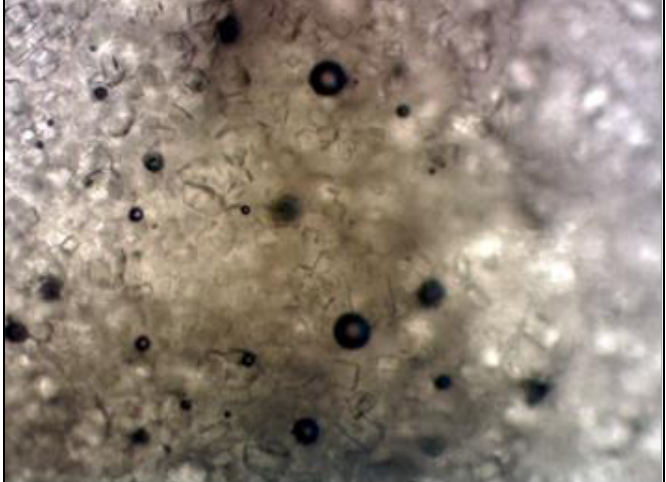
Figura 9: Imagen Segmentada. Fuente: Los autores, (2018).